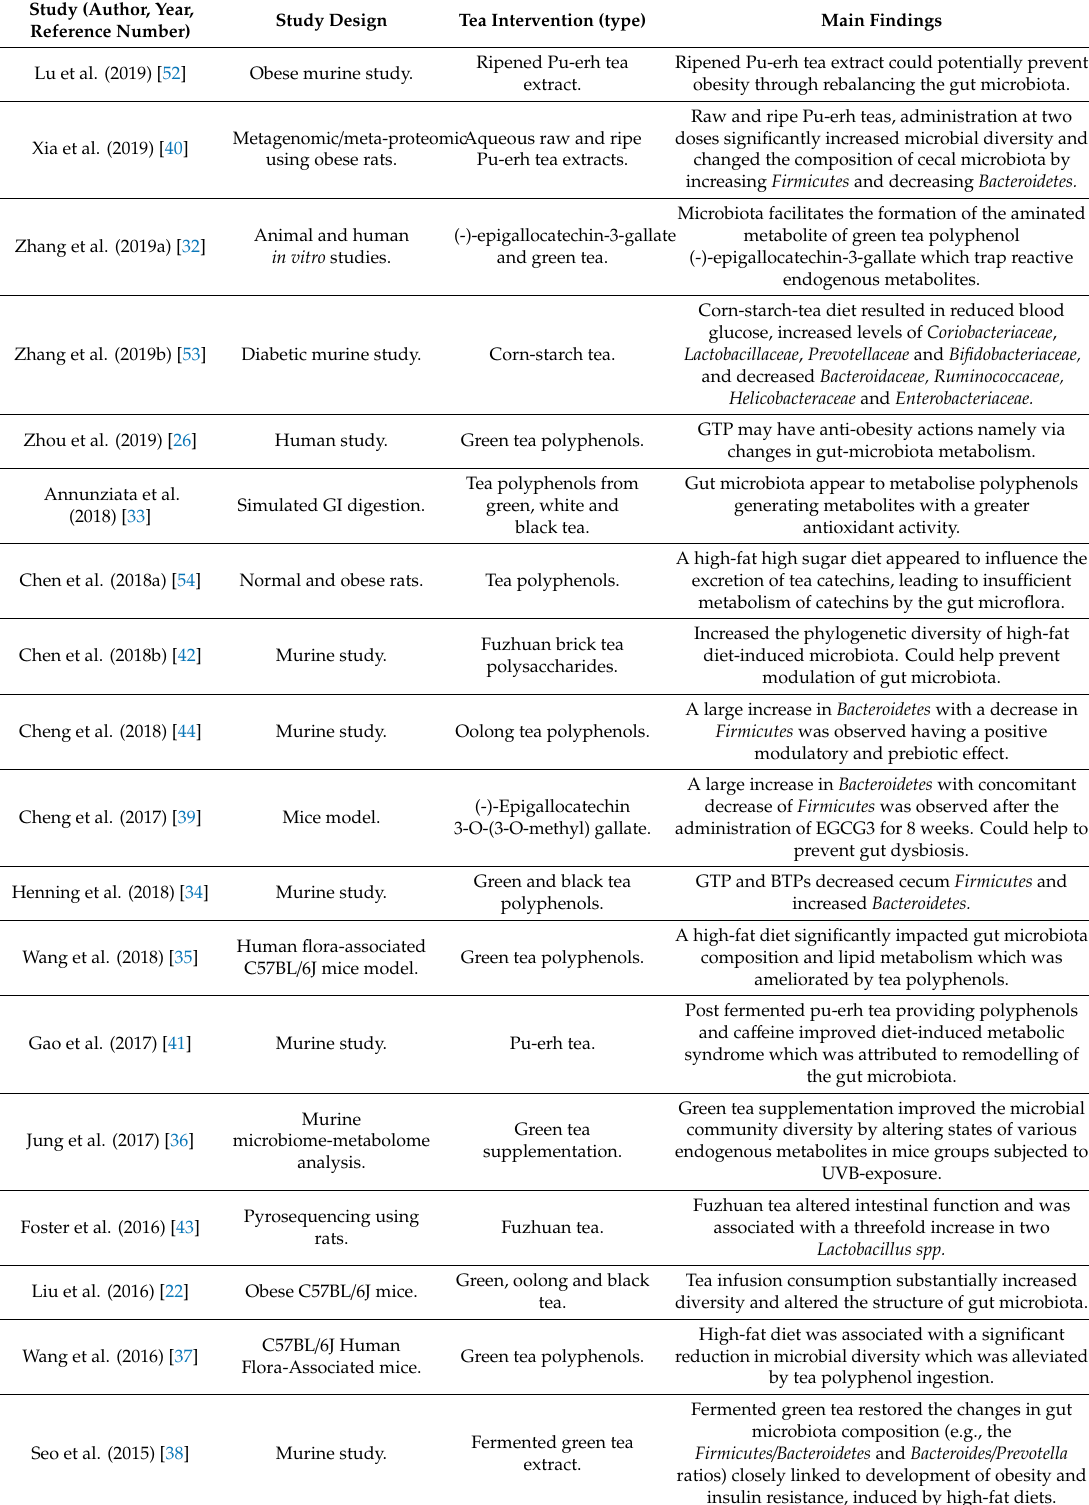
Table 3. Phase 2: Tea compounds and the gut microbiome: Evidence from mechanistic